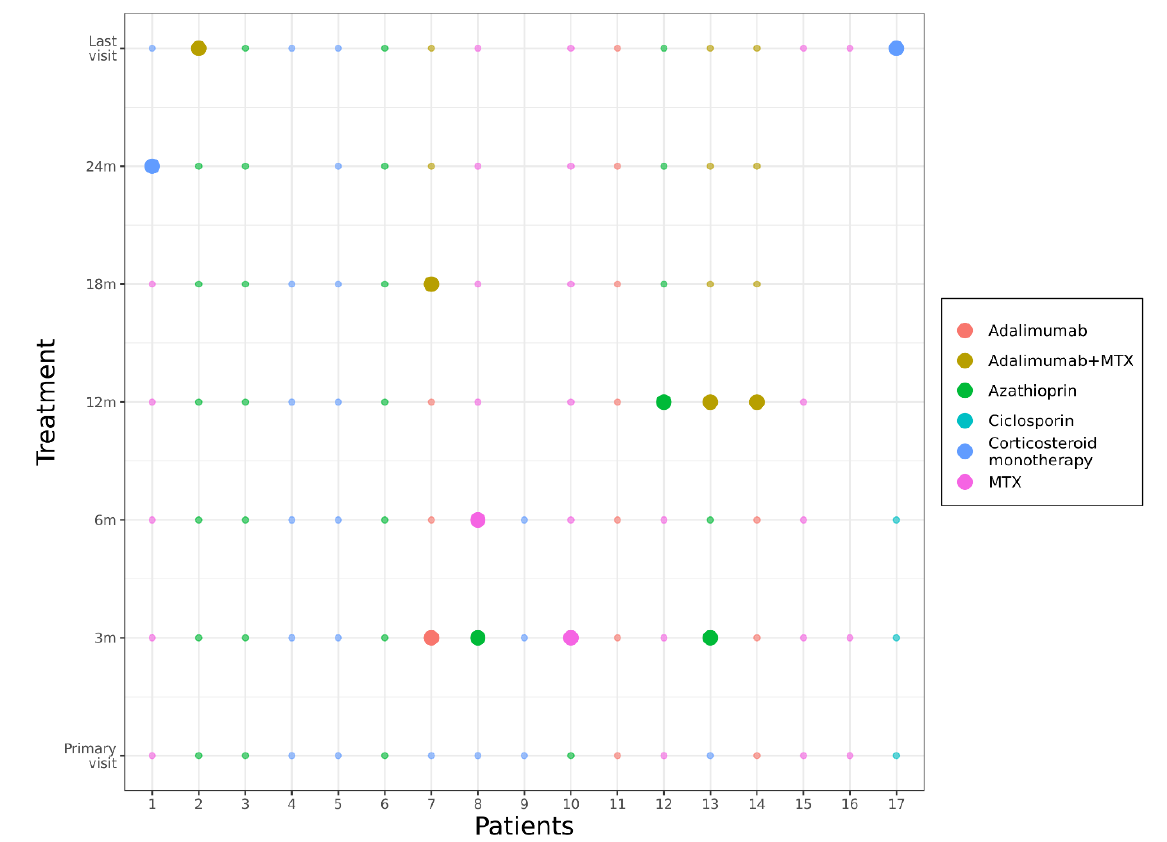
Figure 4. Shows the different treatment options and the switch of therapy of each patient during the follow up in months (m). Each color represents a different therapy; the larger dots indicate a switch of immunosuppression. Patient no. 9, 15, 16, 17 did not have complete